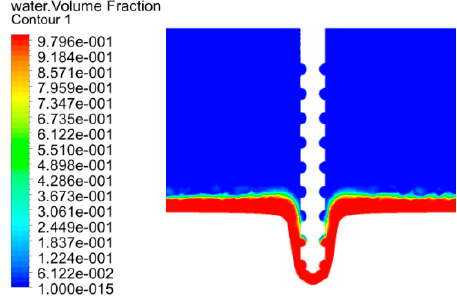
Figure 4. Distribution diagram of gas and liquid.